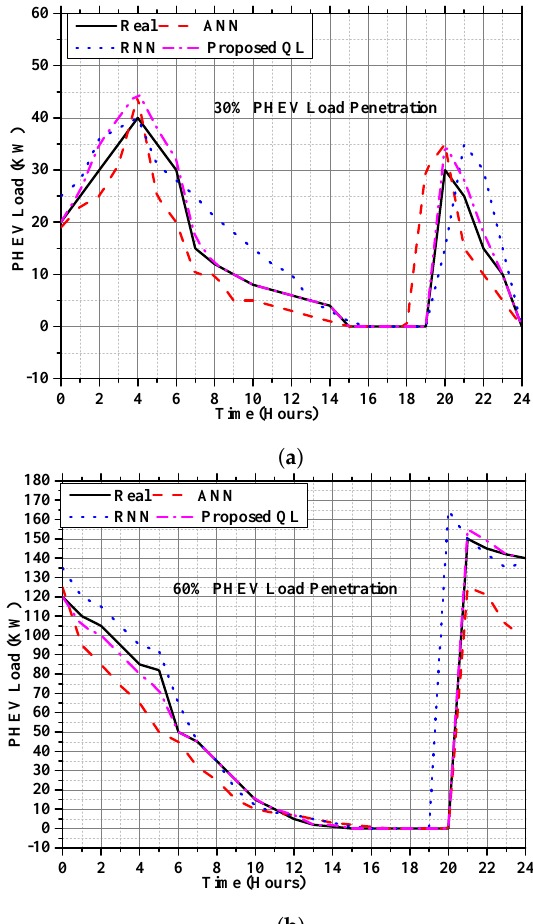
Figure 9. Smart charging PHEV load forecasting with a 30% and 60% penetrations. ( a ) Smart charging PHEV load forecasting with a 30% penetration. ( b ) Smart charging PHEV load forecasting with a 60%